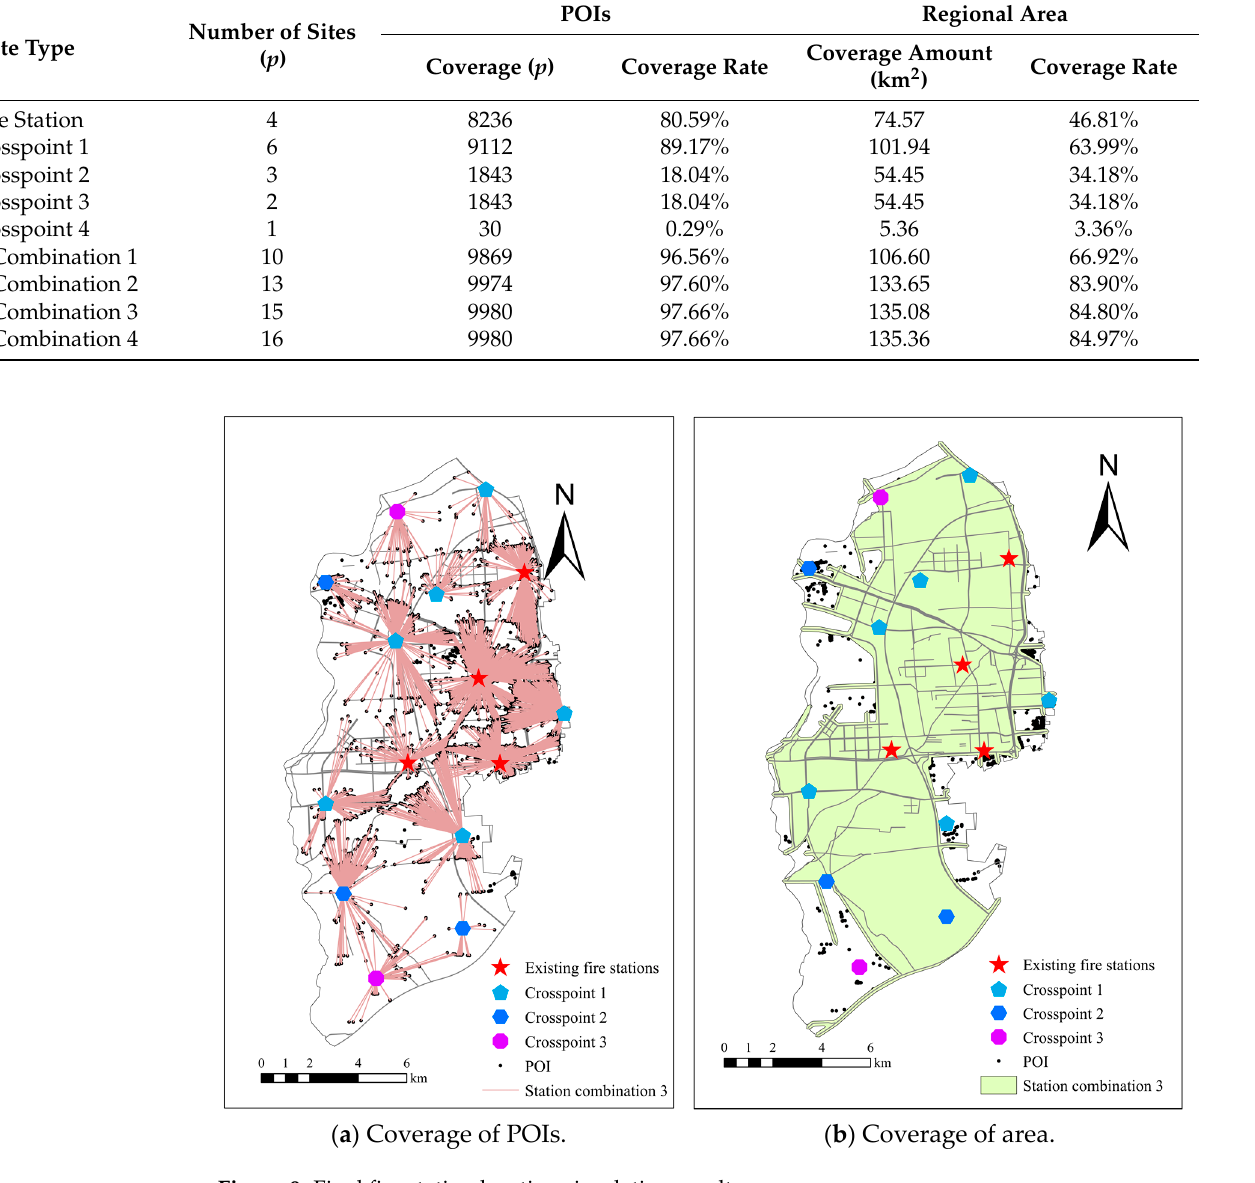
Figure 9. Final fi re station location simulation results. Figure 9. Final fire station location simulation